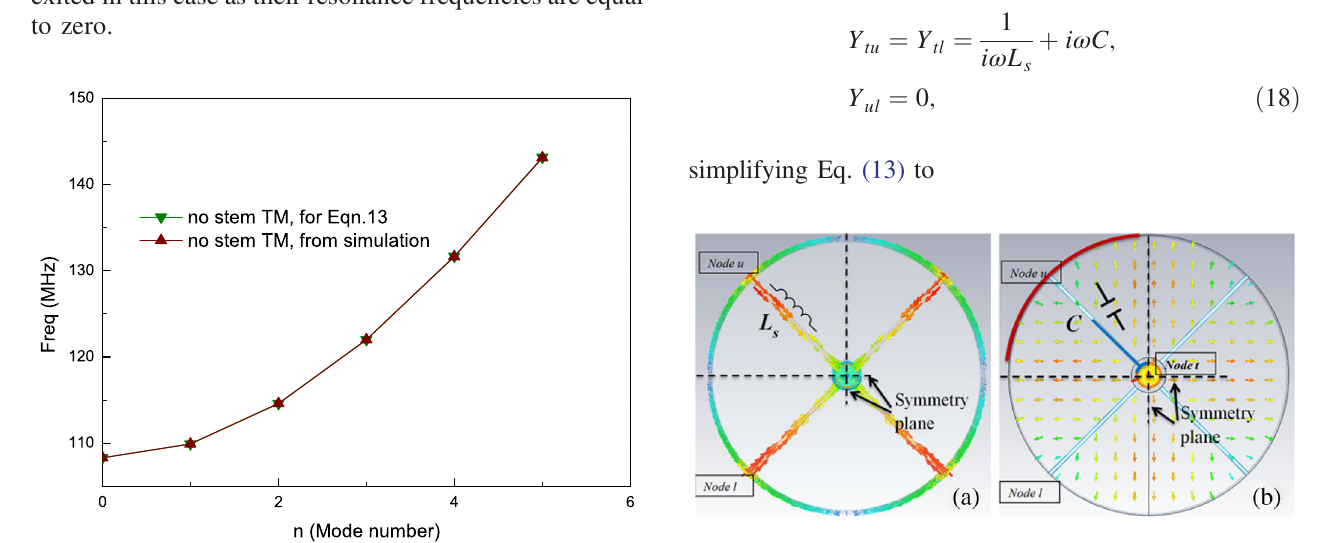
FIG. 7. Equivalent inductances and capacitances of one cavity cell for the cross configuration and the alternating V-configuration. -modes for an Alvarez-type n (a): current path inductance L ; (b): capacitance C from the electric s field between red tank wall area and blue drift tube